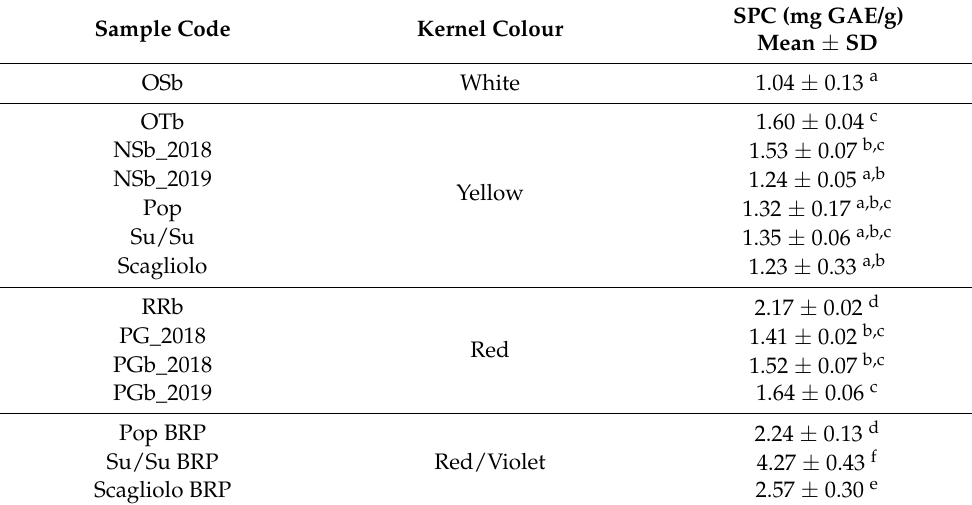
Table 3. Content of soluble phenolic compounds (SPC) in corn varieties. Sample